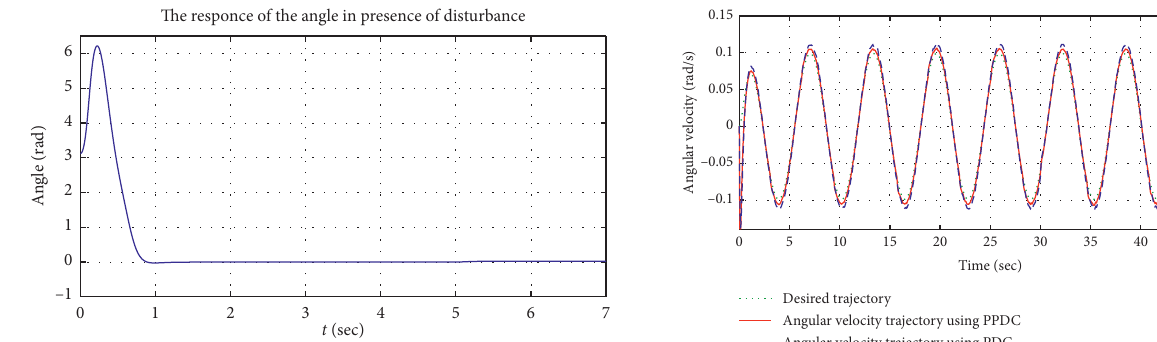
( t ) � θ ( t ) . Figure 5: Angular velocity trajectories using PDC and PPDC 1 approaches.